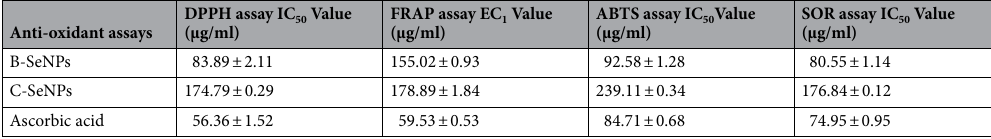
Table 3. Anti-oxidant activities of B-SeNPs and C-SeNPs.